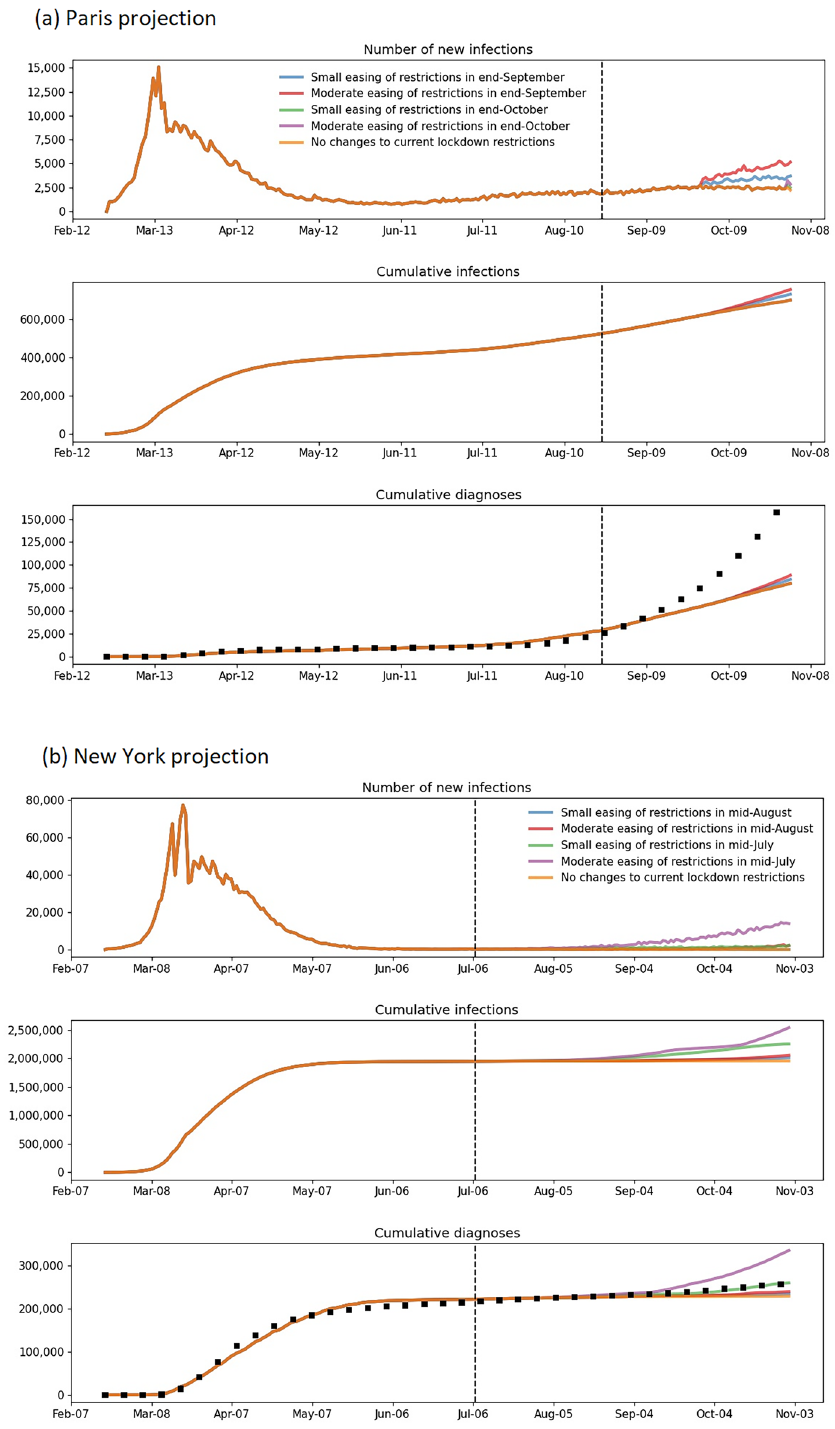
Figure 2. Number of new infections, cumulative infections, and cumulative diagnoses in ( a ) Paris and ( b ) New York from February to October 31, 2020. The dashed vertical line represents the start of the model projection period, the black squares the actual data and the colored lines the scenarios